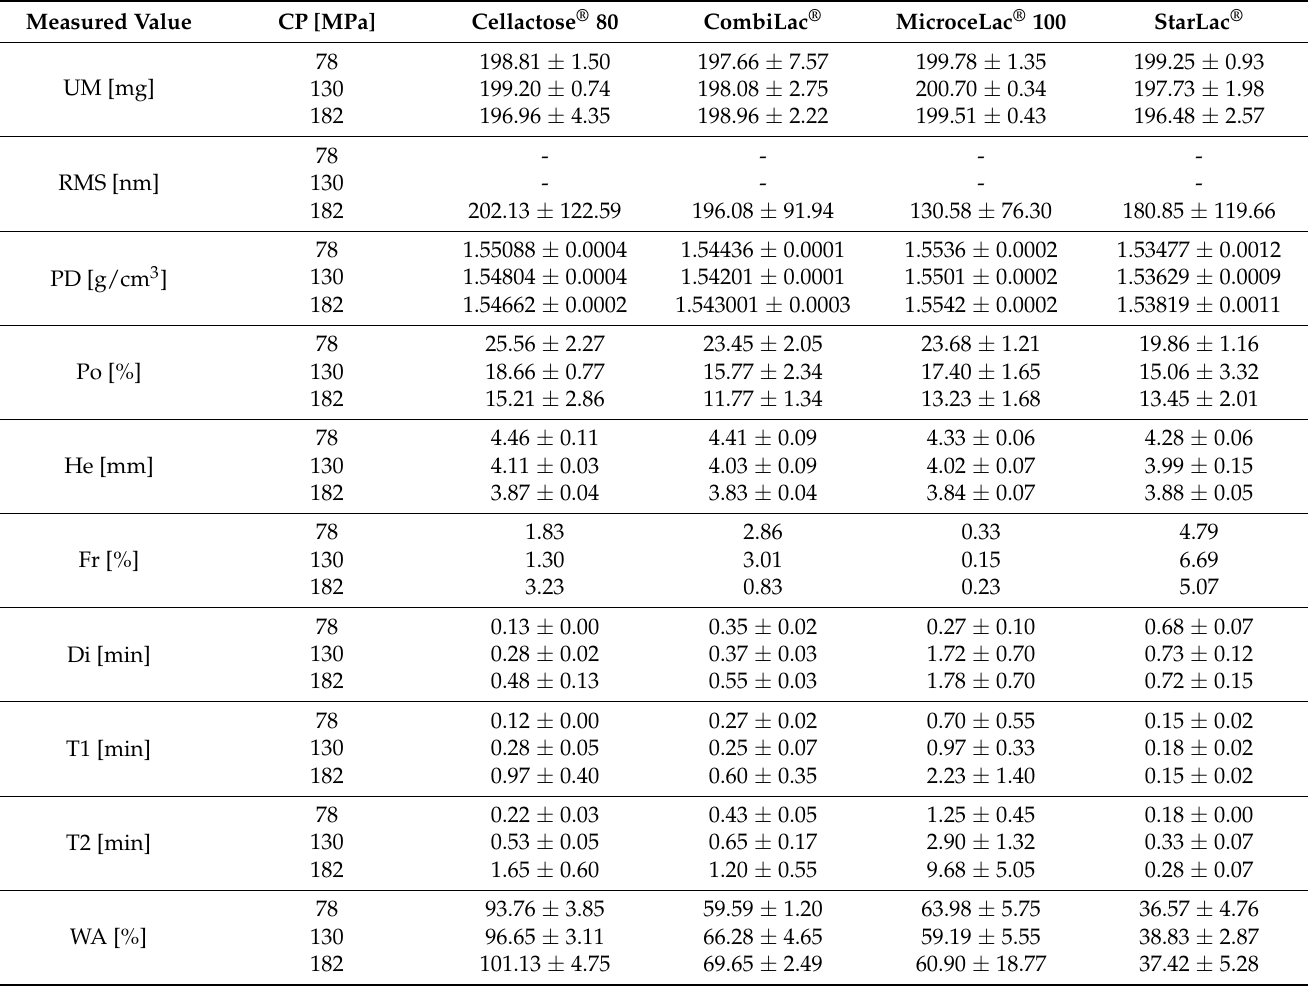
Table 4. Properties of